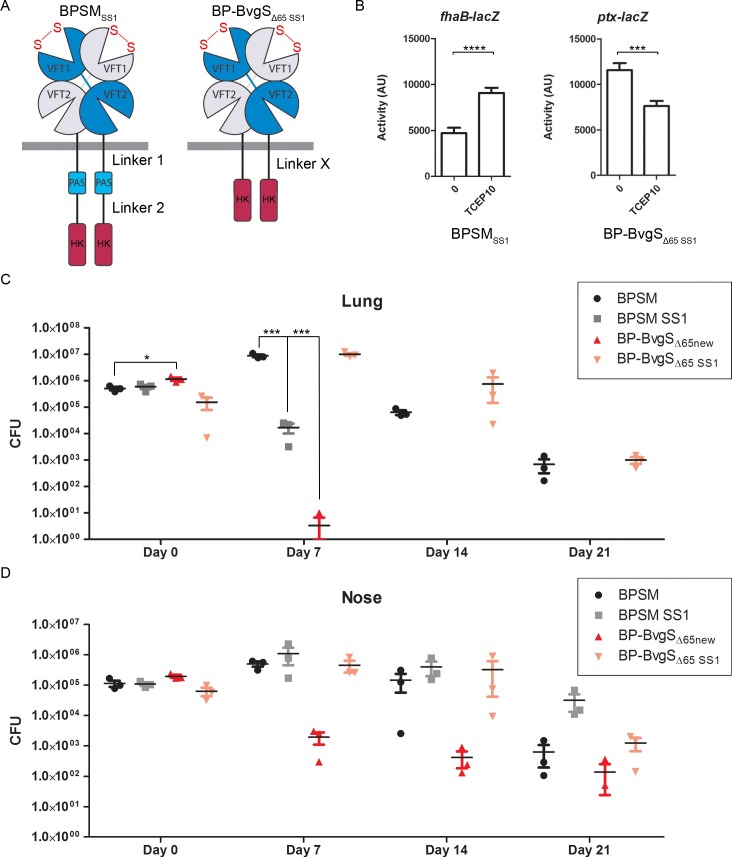
Characterization of strains used in this study and colonization of the lungs and noses of mice.A. Schematic representation of the BvgS variants present in BPSMSS1 and BPSM-BvgSΔ65-SS1 (see legend of Fig 1). Disulfide bound formation between the two lobes of the VFT1 domain is indicated with ‘S-S’. B. Activities of the variants as measured using the ptx-lacZ or fhaB-lacZ reporter systems. The strains were grown in standard conditions (0), and where indicated 10 mM Tris(2-carboxyethyl)phosphine hydrochloride (TCEP 10) was added to reduce the S-S bond in VFT1. The measurements were performed at least three times, and the means and standard errors of the mean are given. Statistical analyses were performed, and significant p values are indicated (****, p<0.0001, *** p<0.001). C and D. Numbers of colony-forming units (CFUs) recovered at the indicated time points from the lungs (C) or the noses (D) of mice infected with BPSM or BP-BvgSΔ65. Prior to inoculation, the bacteria were grown in standard conditions. Three mice were sacrificed at each time point for each bacterial strain. The means and standard errors of the means are shown. Statistical analyses were performed for each data point using the corresponding BPSM data point as a control. Significant p values are indicated (***, p<0.001; *, p<0.05). The other data present p-values >0.05.